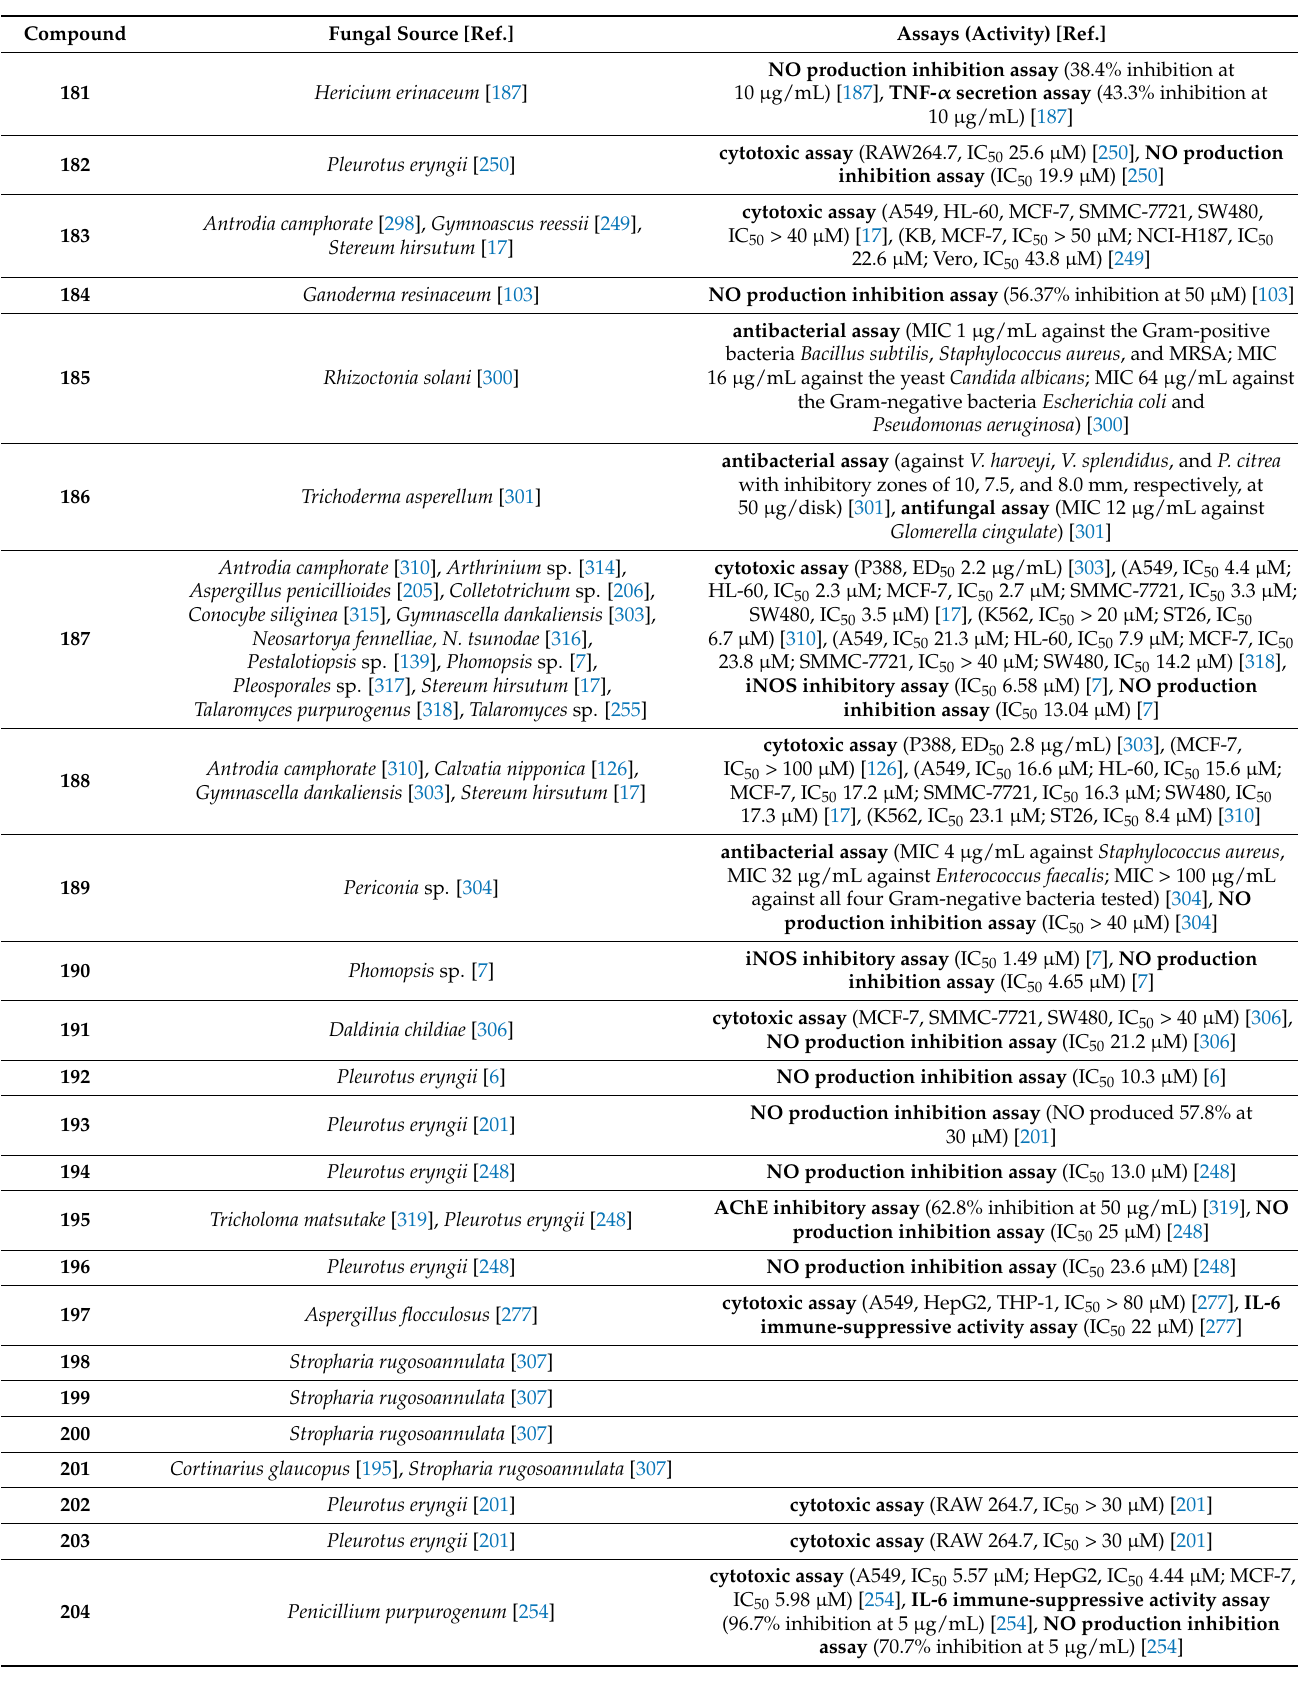
Compound Fungal Source